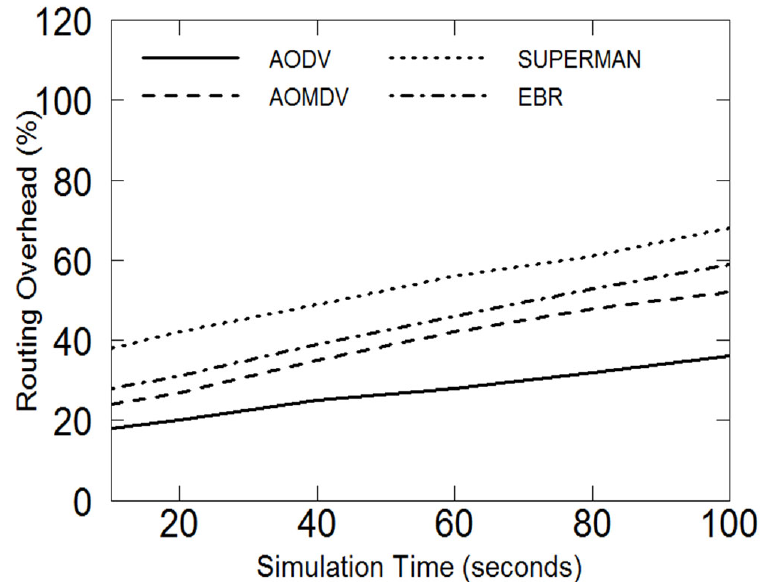
Figure 15. Routing overhead vs. simulation time (with attack).